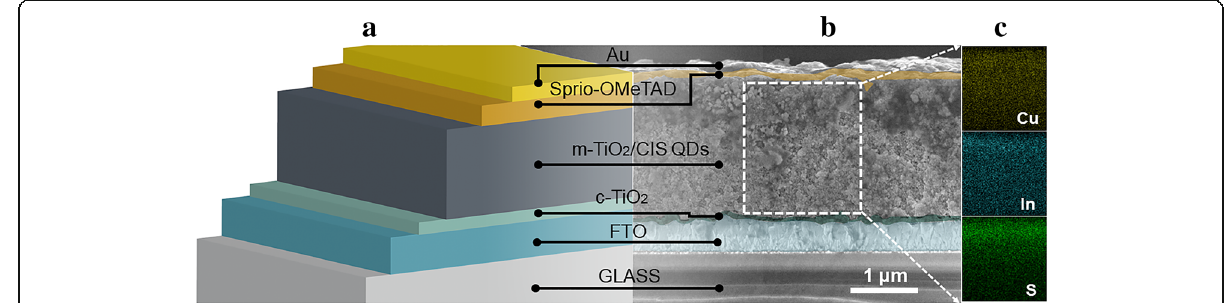
Fig. 1 a Schematic of the device architecture. b The cross-sectional SEM image of the solar cell (corresponding to the sample prepared with 20 cycles and annealed at 400 °C). c The elemental distribution maps of Cu, In, and S elements in TiO 2 /CIS layer